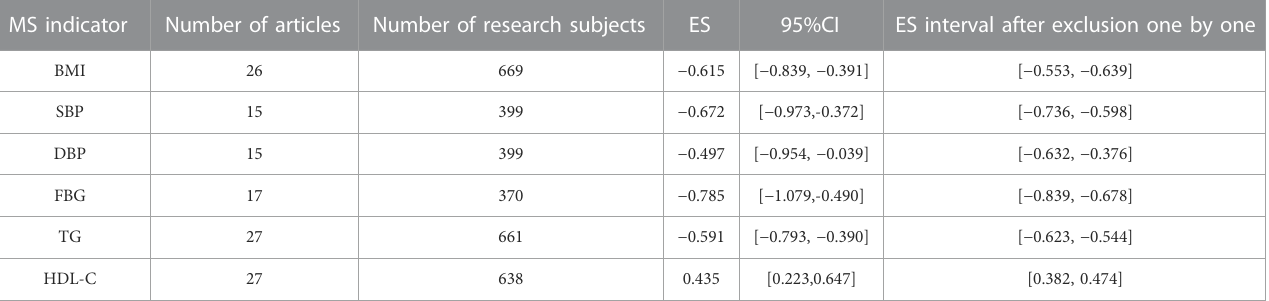
TABLE 3 Results of the sensitivity